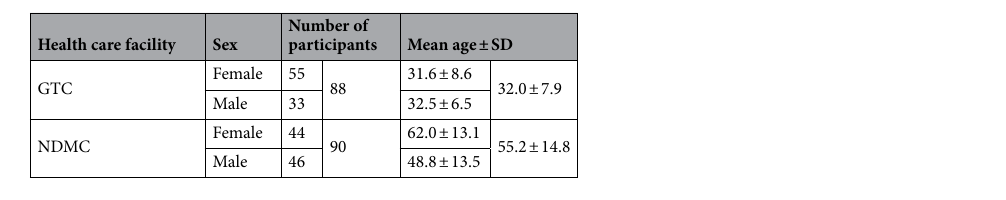
Table 2. Participants’